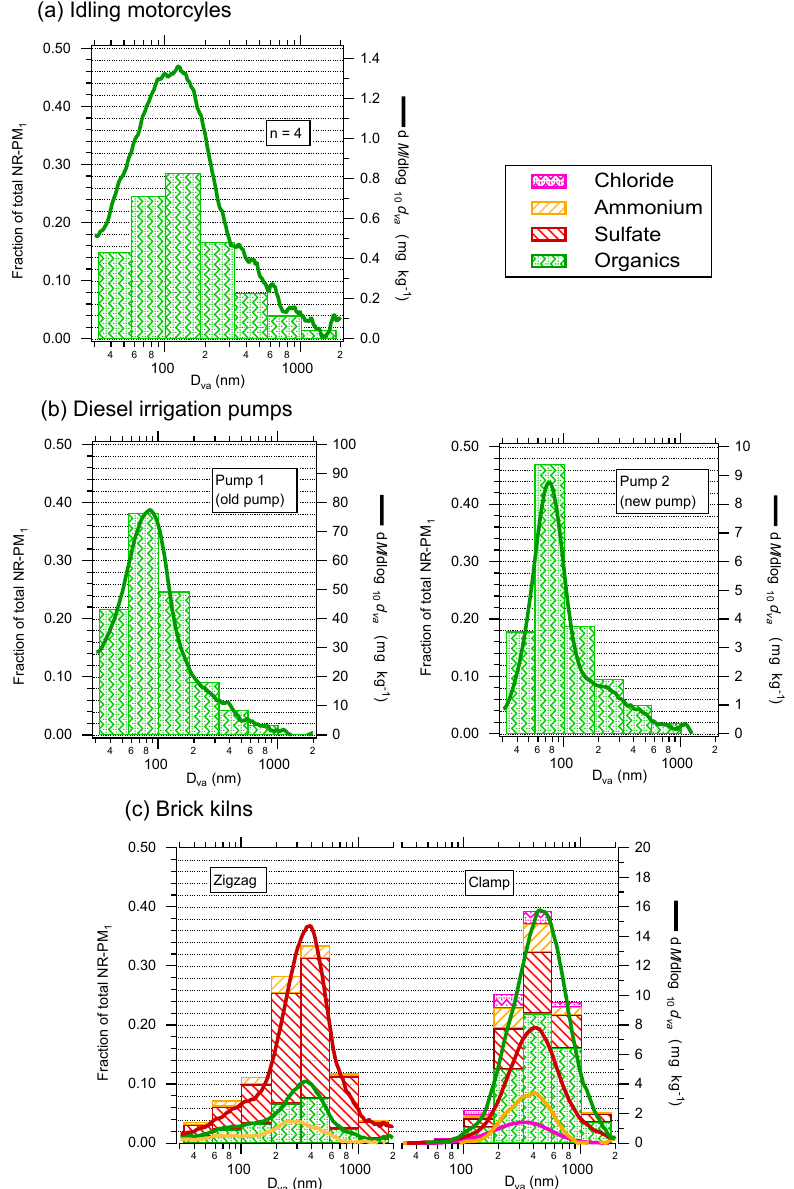
Figure 3. Size-resolved emission factors of (a) idling motorcycles, (b) diesel-powered irrigation pumps, and (c) brick kilns. Continuous species-specific mass size distributions normalized by the test-integrated emission factor are shown as solid lines. Cumulative binned mass size distributions normalized by the total non-refractory submicron aerosol mass (NR-PM 1 ) are shown as stacked bars. The distribution bins are 32, 56, 100, 180, 320, 560, 1000, and 1800nm. All sizes are shown as vacuum aerodynamic diameters, d va